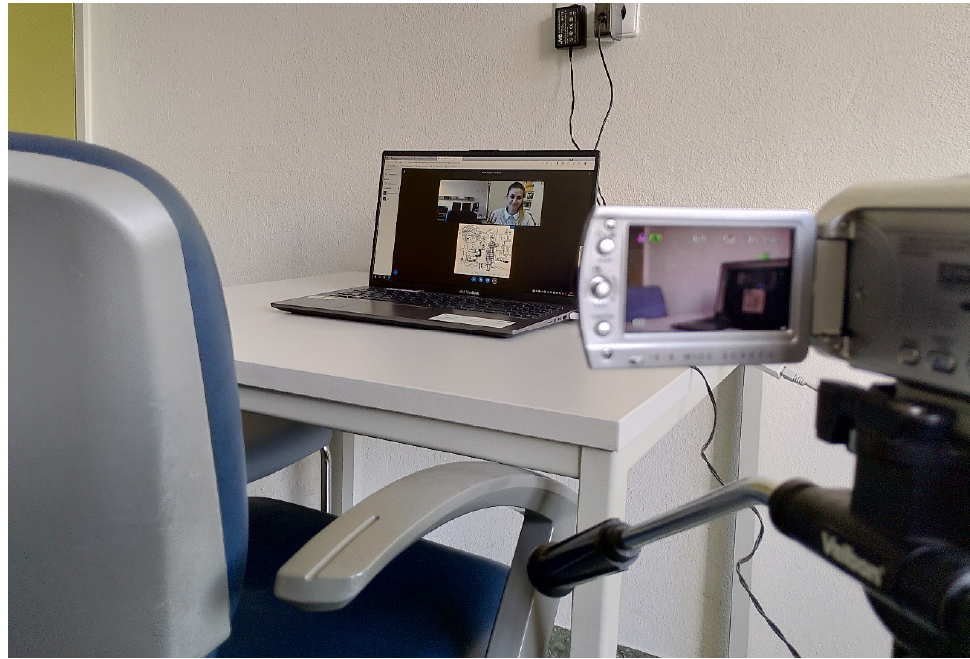
Figure 1. The telediagnostic setting.